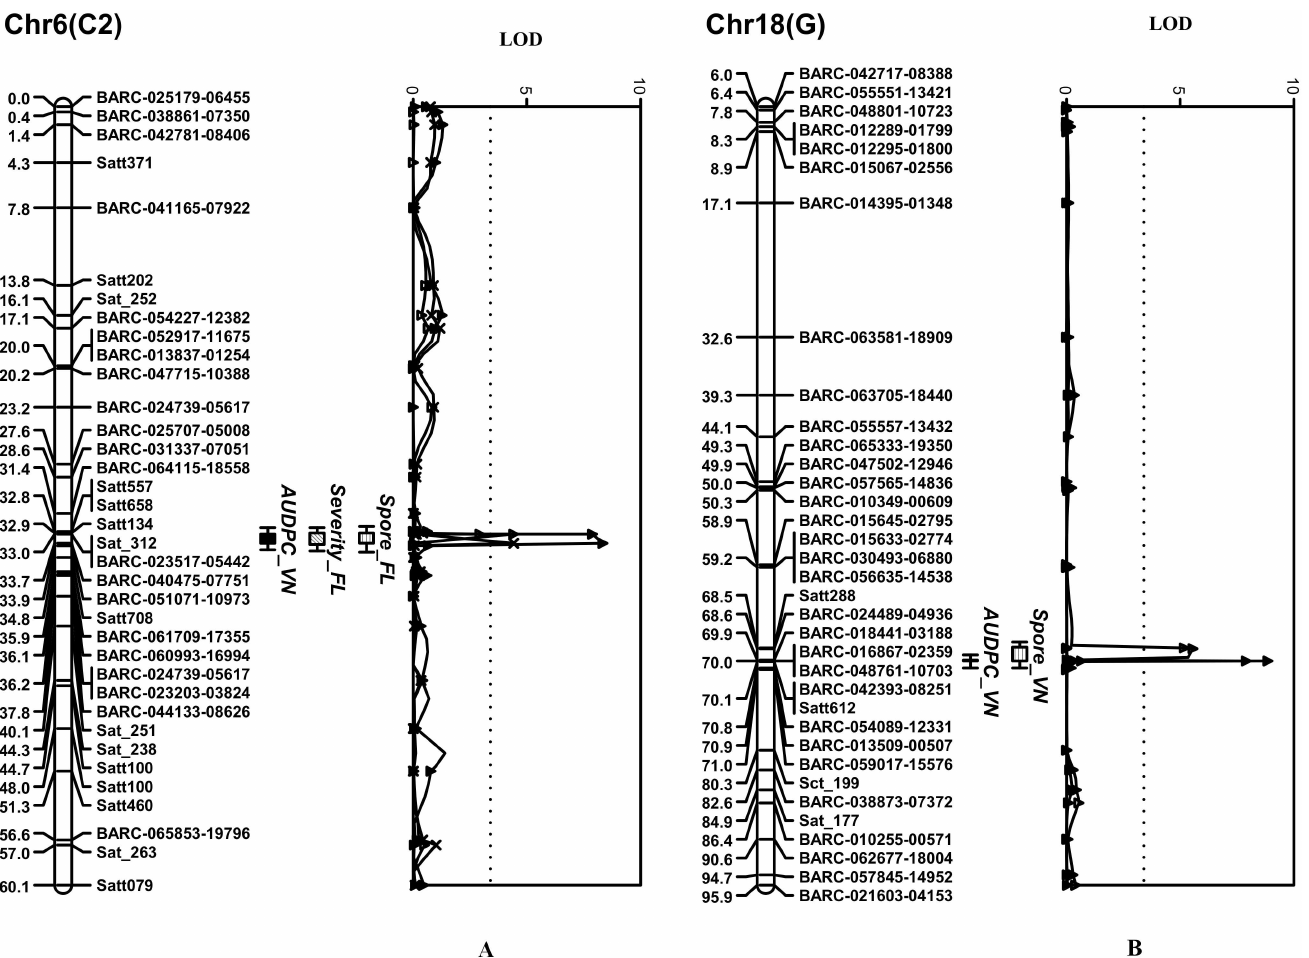
Fig 3. Genomic regions and SNP and SSR markerssignificantly associated with resistance to SBR were consistently detected using the composite interval mapping (CIM) method in the Williams 82 × DT 2000 population. (A) A genomicregionwas mappedto Chr. 6 and closely linked to the Rpp3 locus. (B) A second genomicregionwas mappedto Chr. 18 and closely linked to the Rpp4 locus.